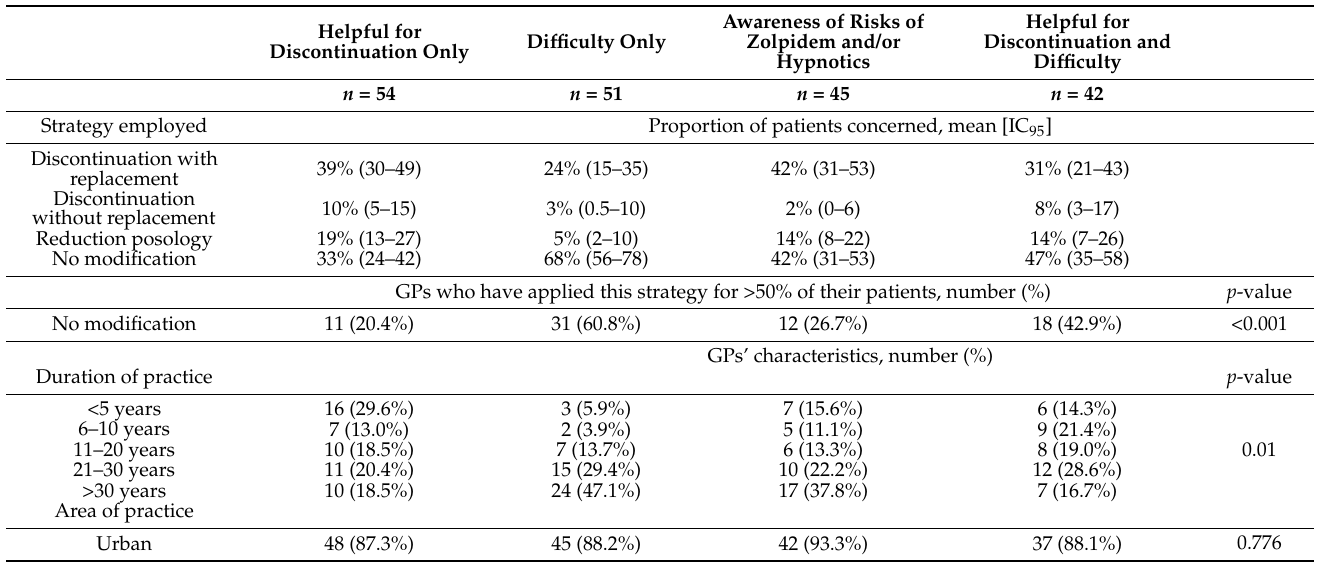
Table 2. Different proportions of patients concerned by each strategy and GPs’ characteristics according to their pattern of perception of the new